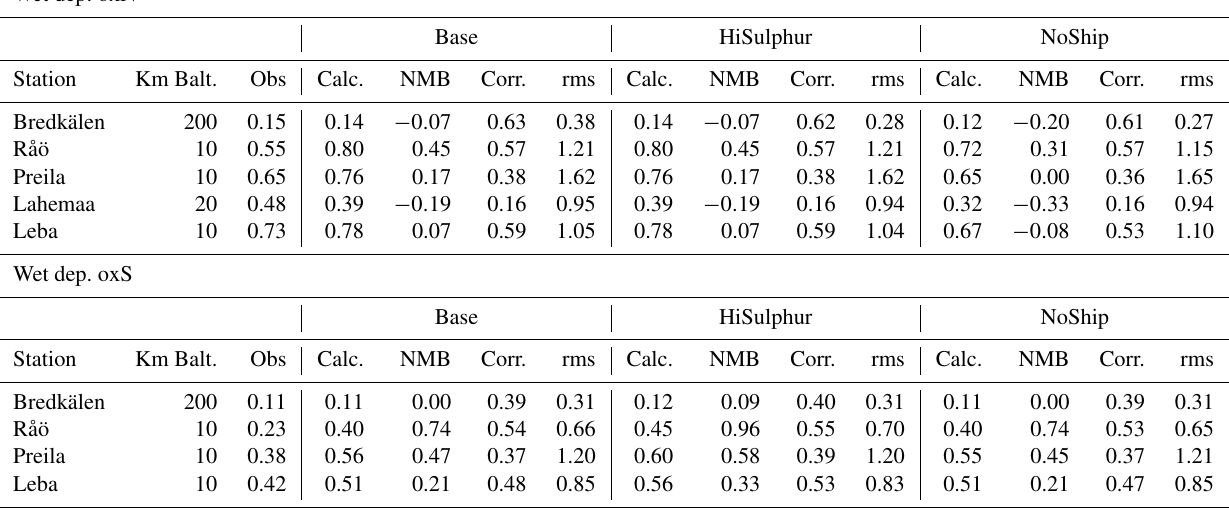
Table 3. Annual average measured (Obs) and model-calculated concentrations (Calc.) in precipitation of oxidised nitrogen in mgNL − 1 and oxidised sulfur in mg ( inS ) L − 1 in 2016 for the present Base, NoShip, and HiSulphur scenarios. Also listed are the normalised mean bias (NMB), the daily correlations (Corr.), and rms errors (rms) between model and measurements. Km Balt. is a classification of the distance in kilometres between the stations and the Baltic Sea coast. The distance is equal to or smaller than the distance listed. The position of the measurement sites and the time-series plots are shown in Appendix